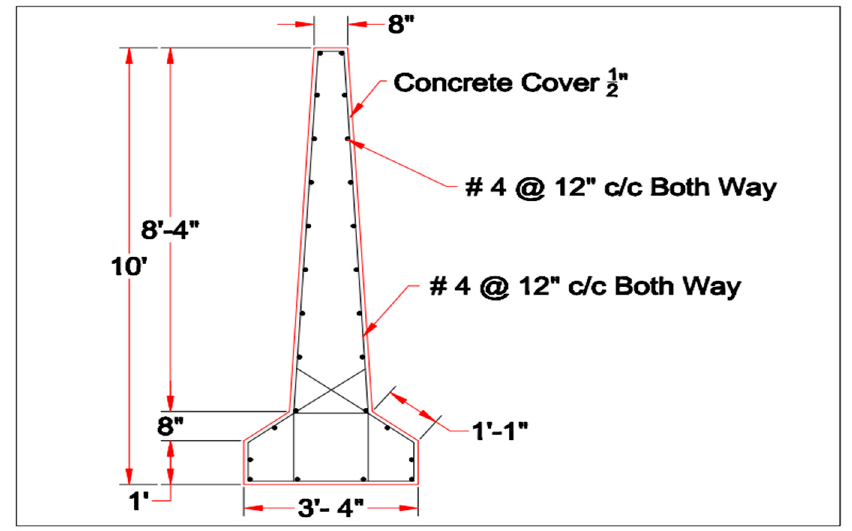
Figure 2. Reinforcement detail of reinforced cement concrete (RCC) wall panels.